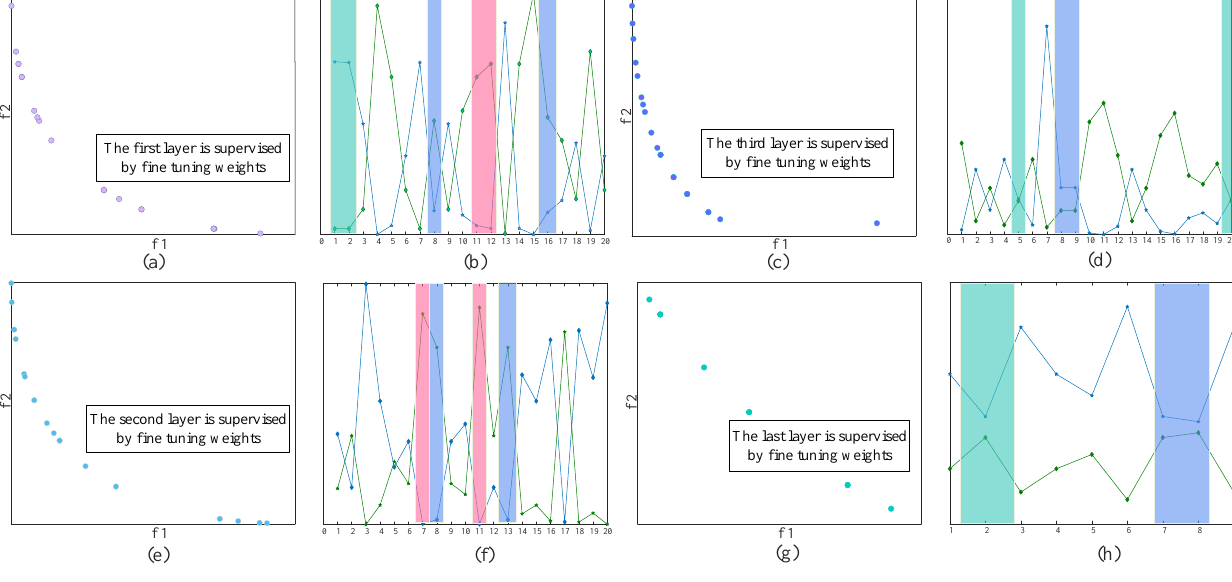
Figure 6. Pareto frontier analysis of the MOJS-ADBN model.